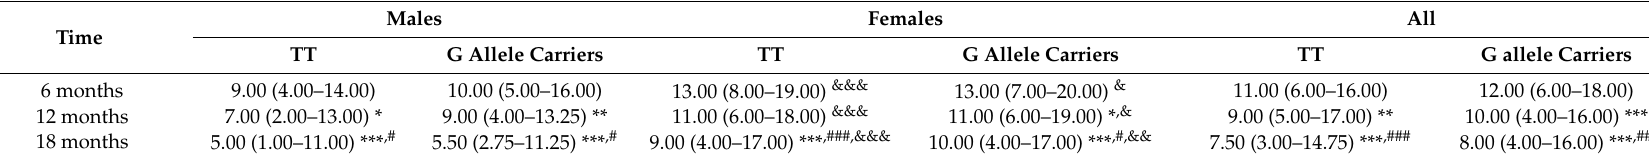
Table 3. Beck Depression Inventory (BDI) scores of the subjects with different genotypes of TNFRII rs1061622 at 6, 12, and 18 months after the earthquake.